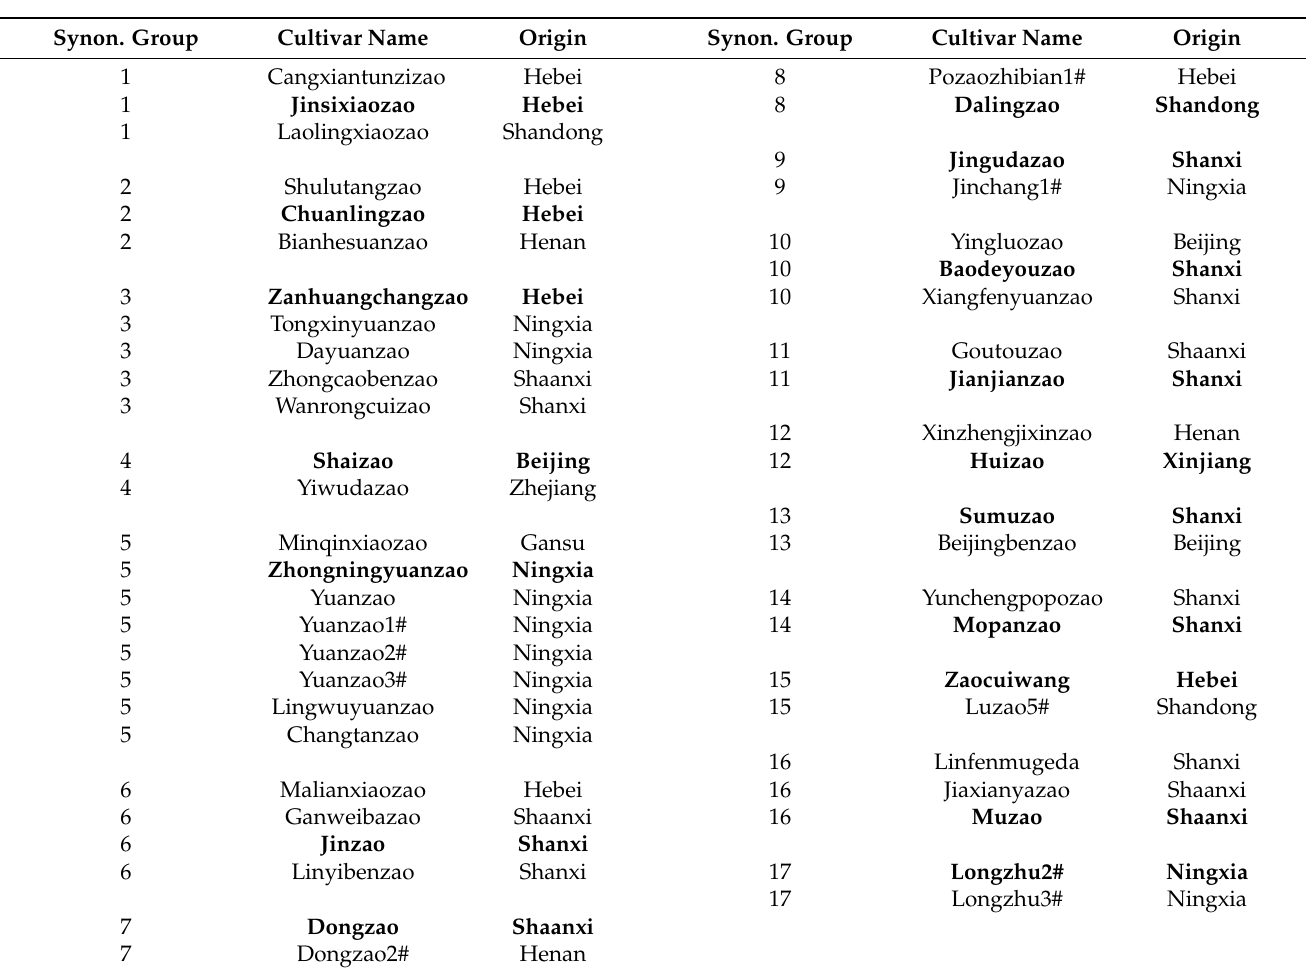
Table 3. List of 17 synonymous groups, including 49 cultivars, identified by SNP markers in the Chinese jujube collection maintained in Yinchuan, Ningxia, China. The cultivar in bold in the table was retained for subsequent diversity analysis. Synon.